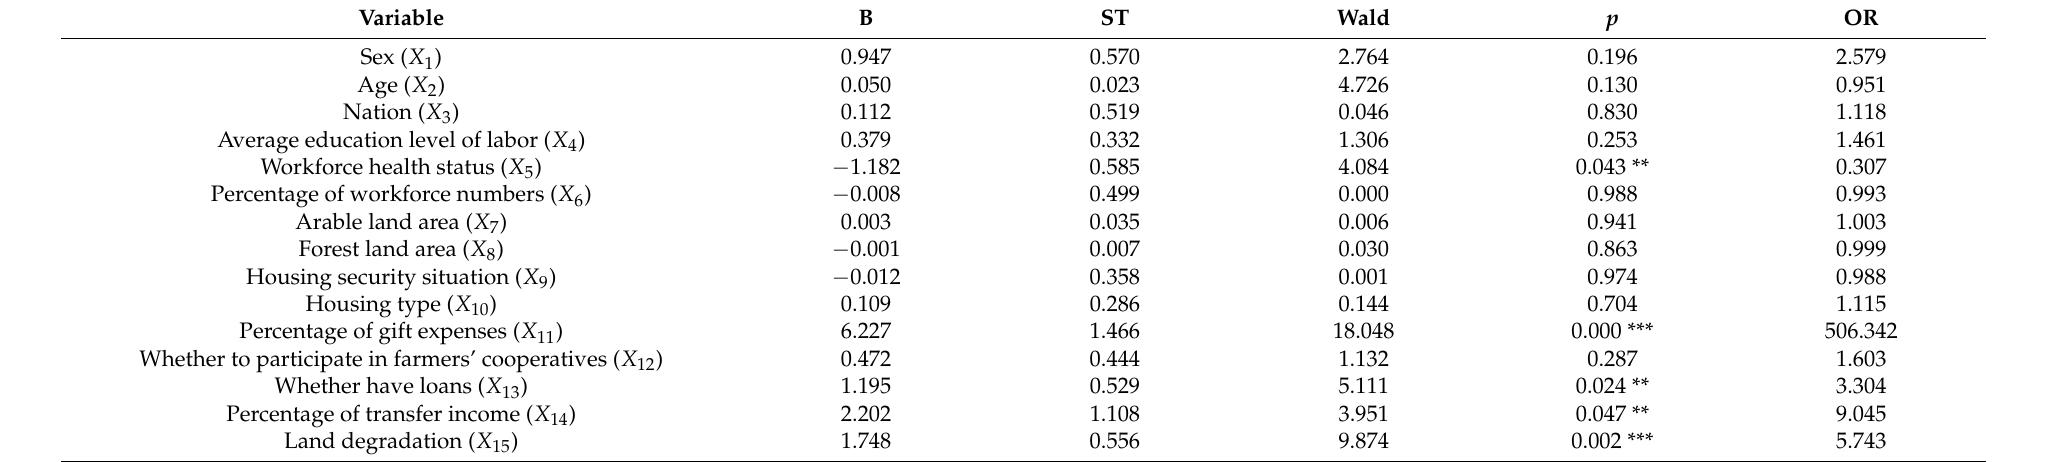
Table 4. Test interaction terms with logistic models on the results of decision trees -Step